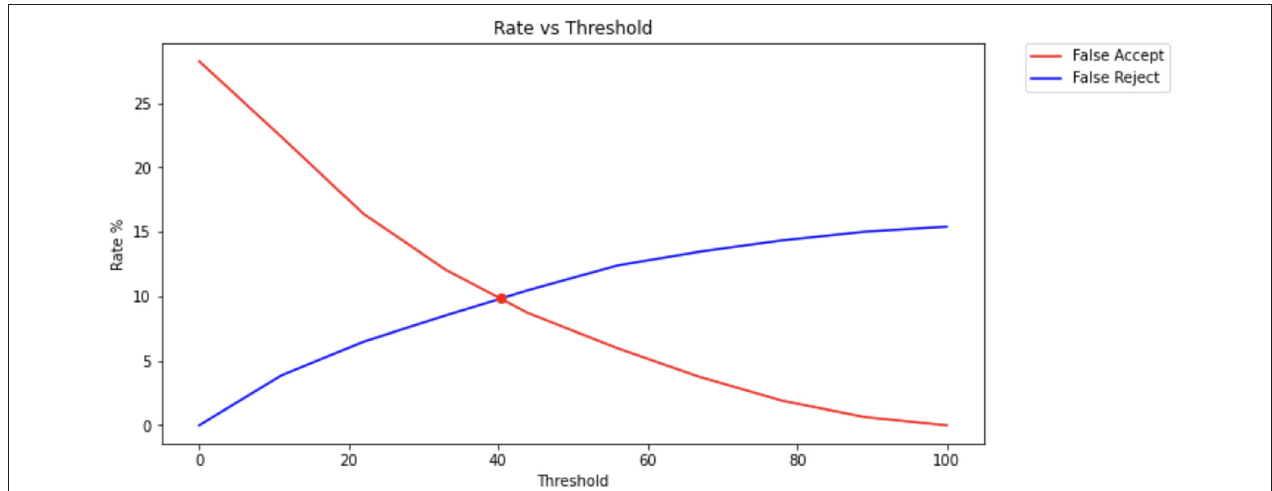
FIGURE 5 | Equal error rate percentage that was achieved by our implementation of the KNN and PCA for finger swiping. This value was approximately equal to that obtained by Frank et al. (2013), despite the fact that fewer features of the finger swiping were